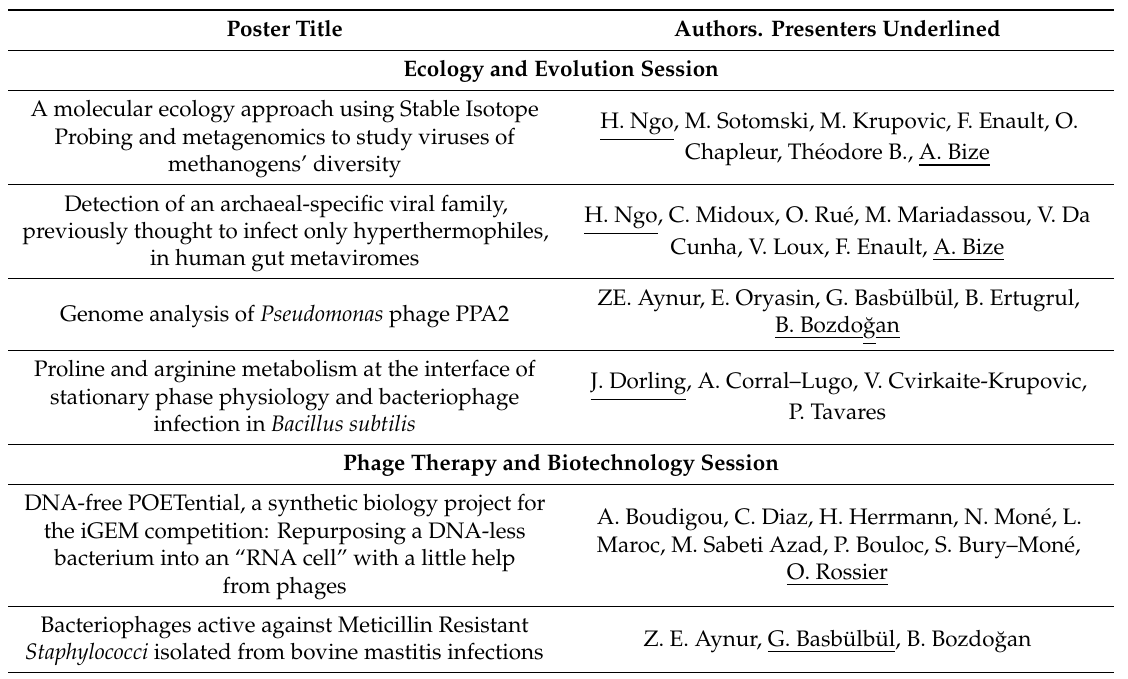
Table 1. List of topics presented during the French Phage Network in Grenoble in